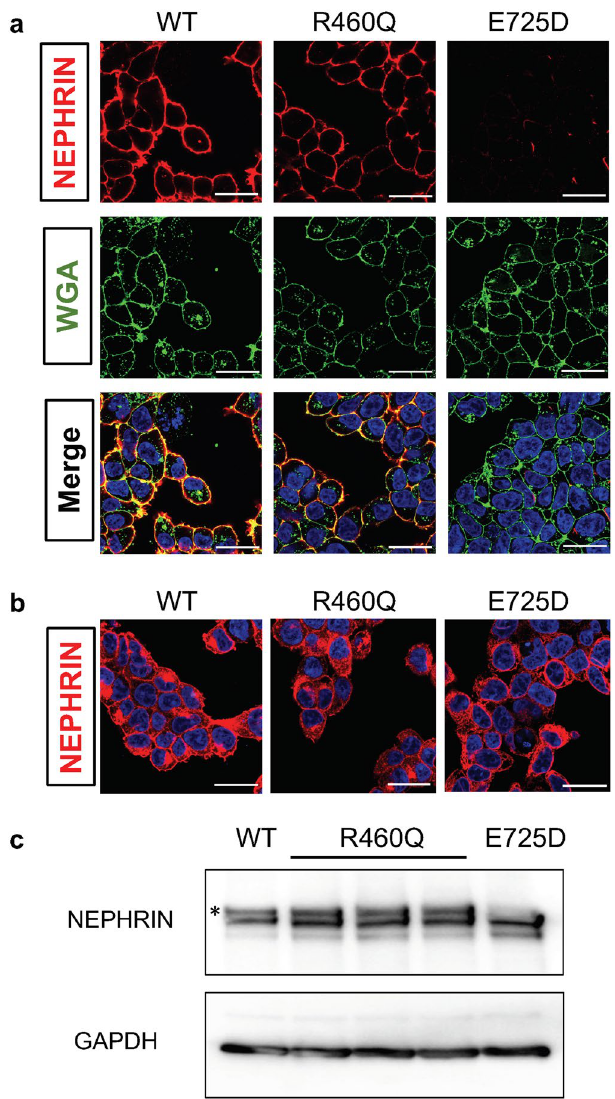
Figure 2. R460Q NEPHRIN mutant protein is localized on the surface in HEK293 cells. ( a ) Immunostaining of HEK293 cells overexpressing wild-type (WT), R460Q mutant (Patient 3), and E725D mutant (Patient 0) NEPHRIN proteins, using an antibody against the extracellular domain of NEPHRIN in the absence of detergent. Wheat germ agglutinin (WGA) binds to the surface glycoproteins. Scale bars, 25 µm. ( b ) Immunostaining of HEK293 cells overexpressing wild-type (WT), R460Q mutant (Patient 3), and E725D mutant (Patient 0) NEPHRIN proteins, using an antibody against the intracellular domain of NEPHRIN in the presence of detergent. Note the comparable expression of the WT and mutant NEPHRIN proteins. Scale bars, 25 µm. ( c ) Western blotting analysis of HEK293 cells overexpressing wild-type (WT), R460Q mutant (Patient 3), and E725D mutant (Patient 0) NEPHRIN. The upper band of NEPHRIN (*) is retained in the R460Q mutant, but is absent in the E725D mutant. Three R460Q mutant clones were analyzed to exclude clonal variability. The result for the E725D mutant is consistent with our previous report 17 . The results from the different parts of the same blot were combined, as depicted by the solid